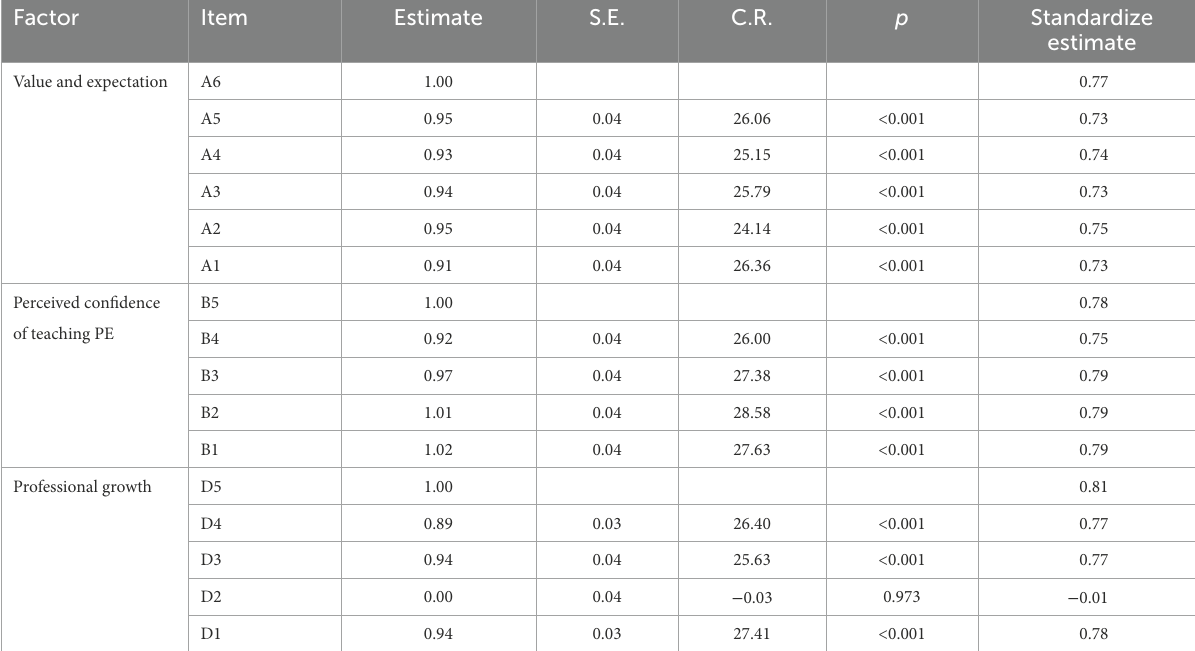
TABLE 4 Factor loadings of original